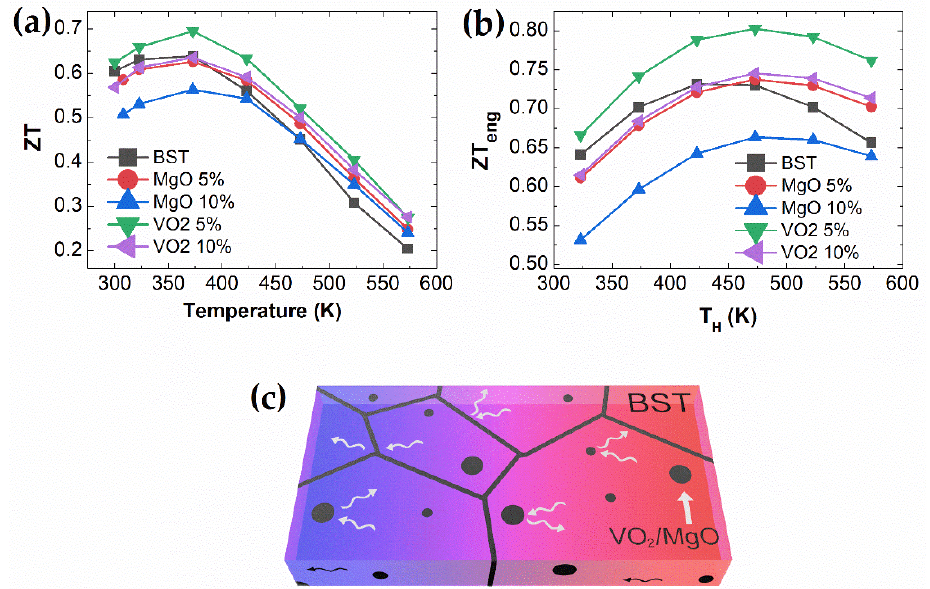
Figure 4. Temperature-dependent ( a ) ZT; ( b ) engineering dimensionless ZT with T L = 300 K; ( c ) schematic of phonon scatterings of MgO and VO 2 BST composites.